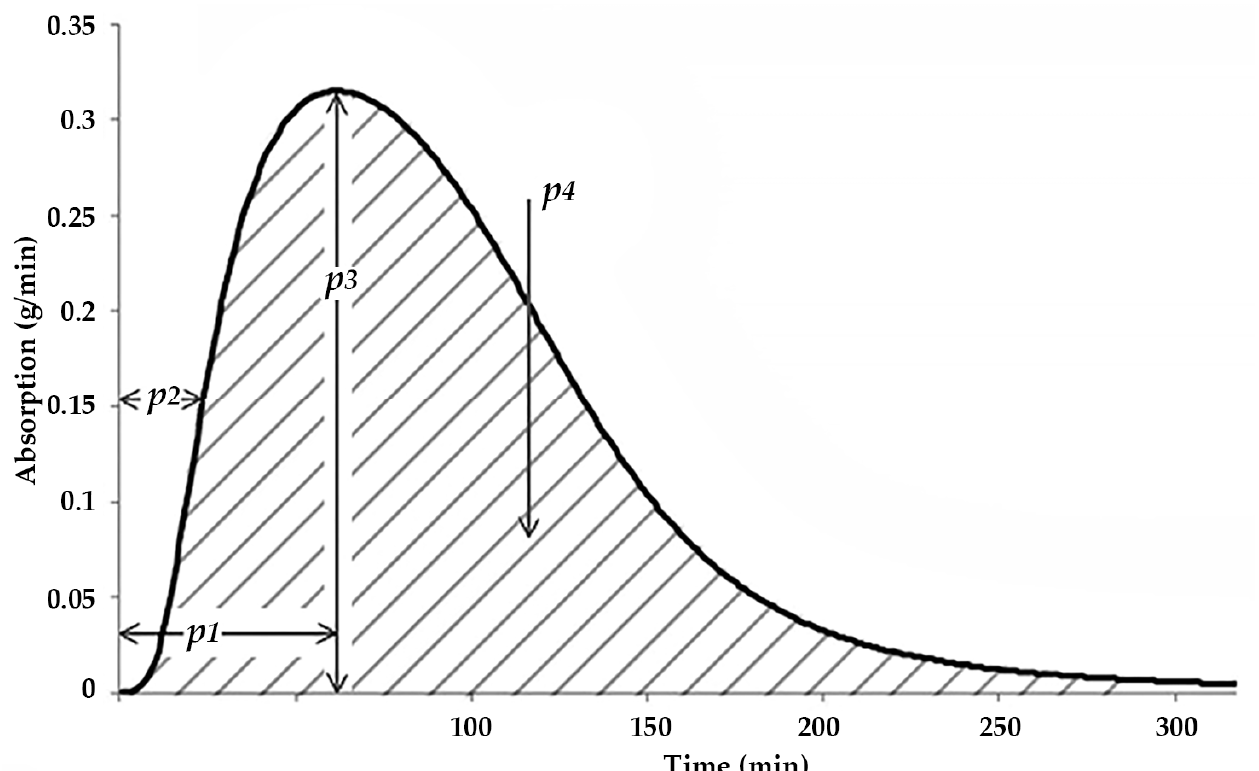
Figure 3. Parameters of the estimated glucose absorption rate curve.